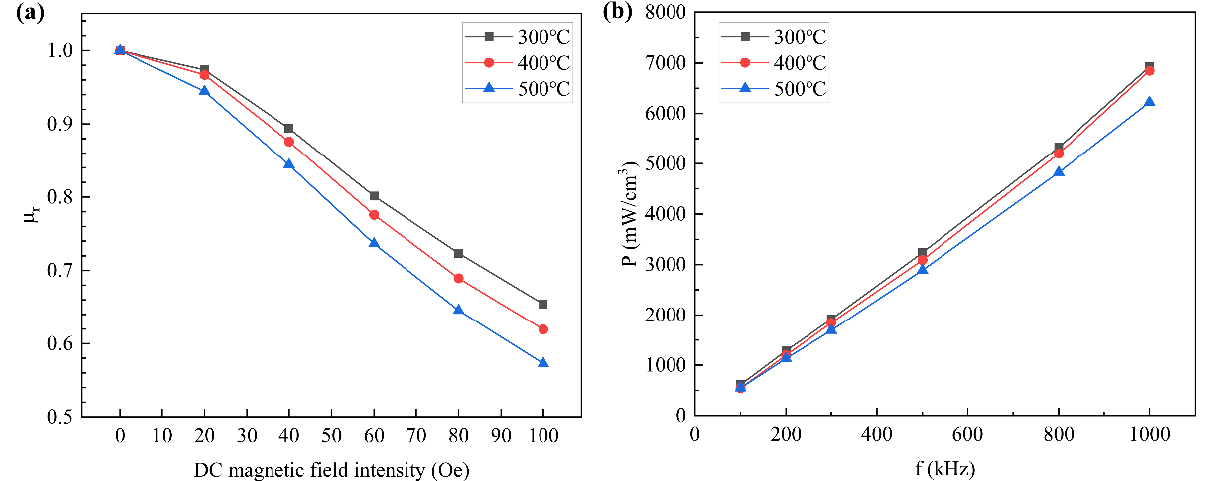
Figure 12. The trend of magnetic properties with annealing temperature (the powder was phosphated and coated with 0.4 wt% PI): ( a ) relative permeability; ( b ) core loss.